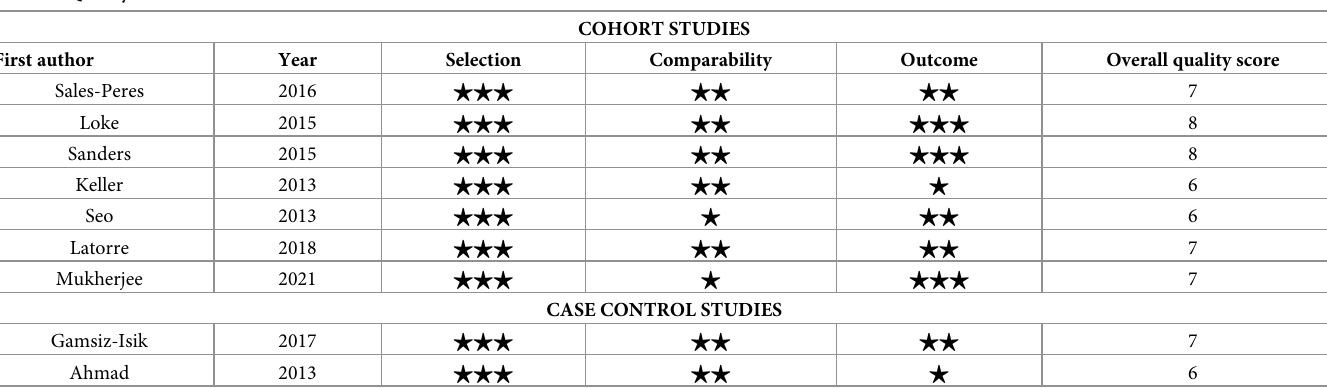
Table 2. Quality assessment of included studies.